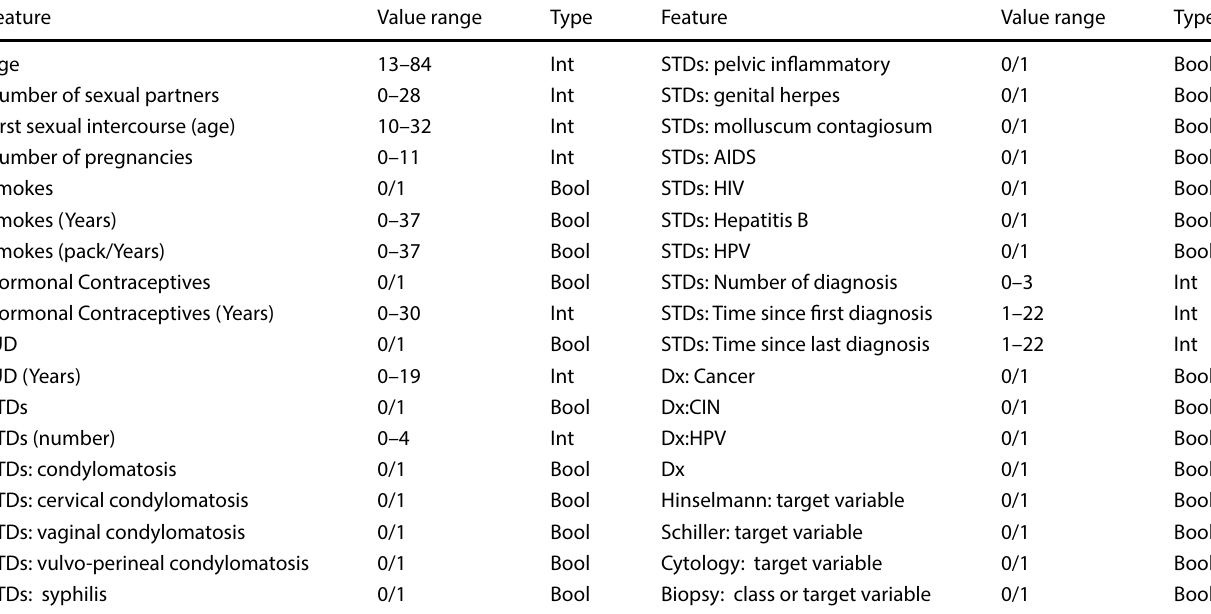
Table 1 Attribute information